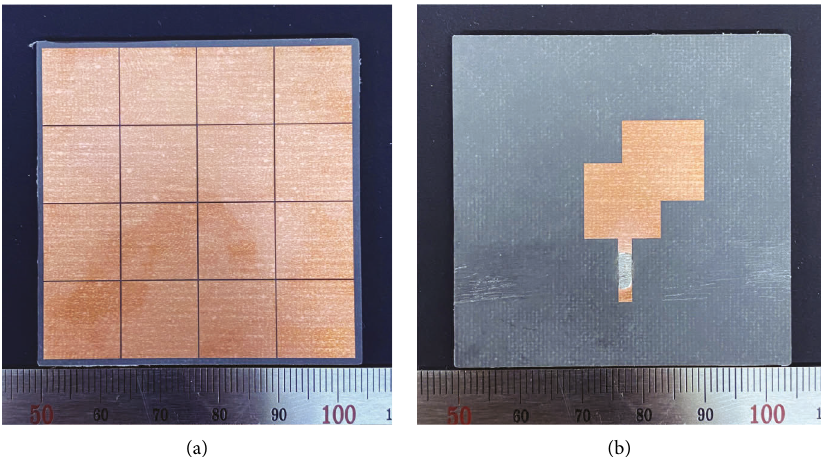
Figure 10: Fabricated sample of the antenna with ε